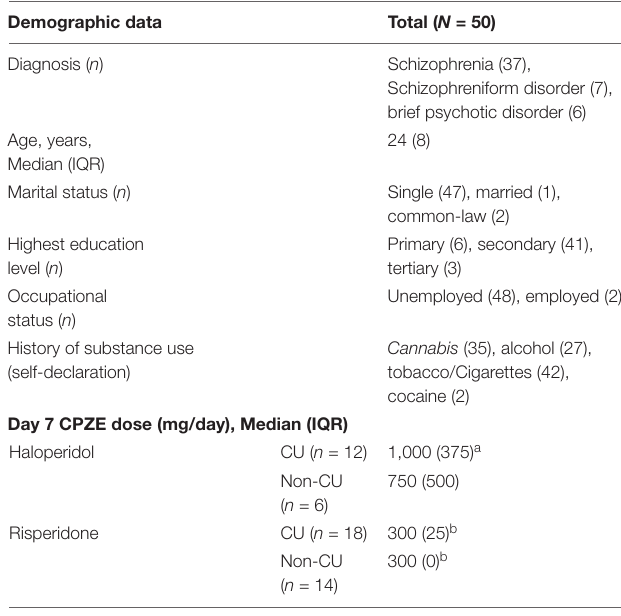
TABLE 1 | Demographic characteristics of study